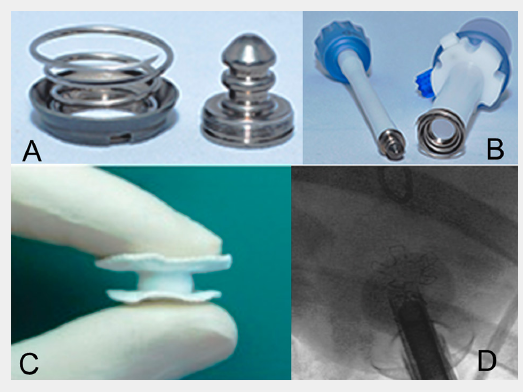
(A) and (B) The Apica TM access and closure device is composed of three parts: the introducer, the coil and the cap (reprinted with permission from Thoratec TM Corporation). (C) and (D) The CardiApex TM device is an apical delivery and plug allowing for full- percutaneous transapical valve procedures (reprinted with permission from Benad Goldwasser, former CEO of Cardiapex